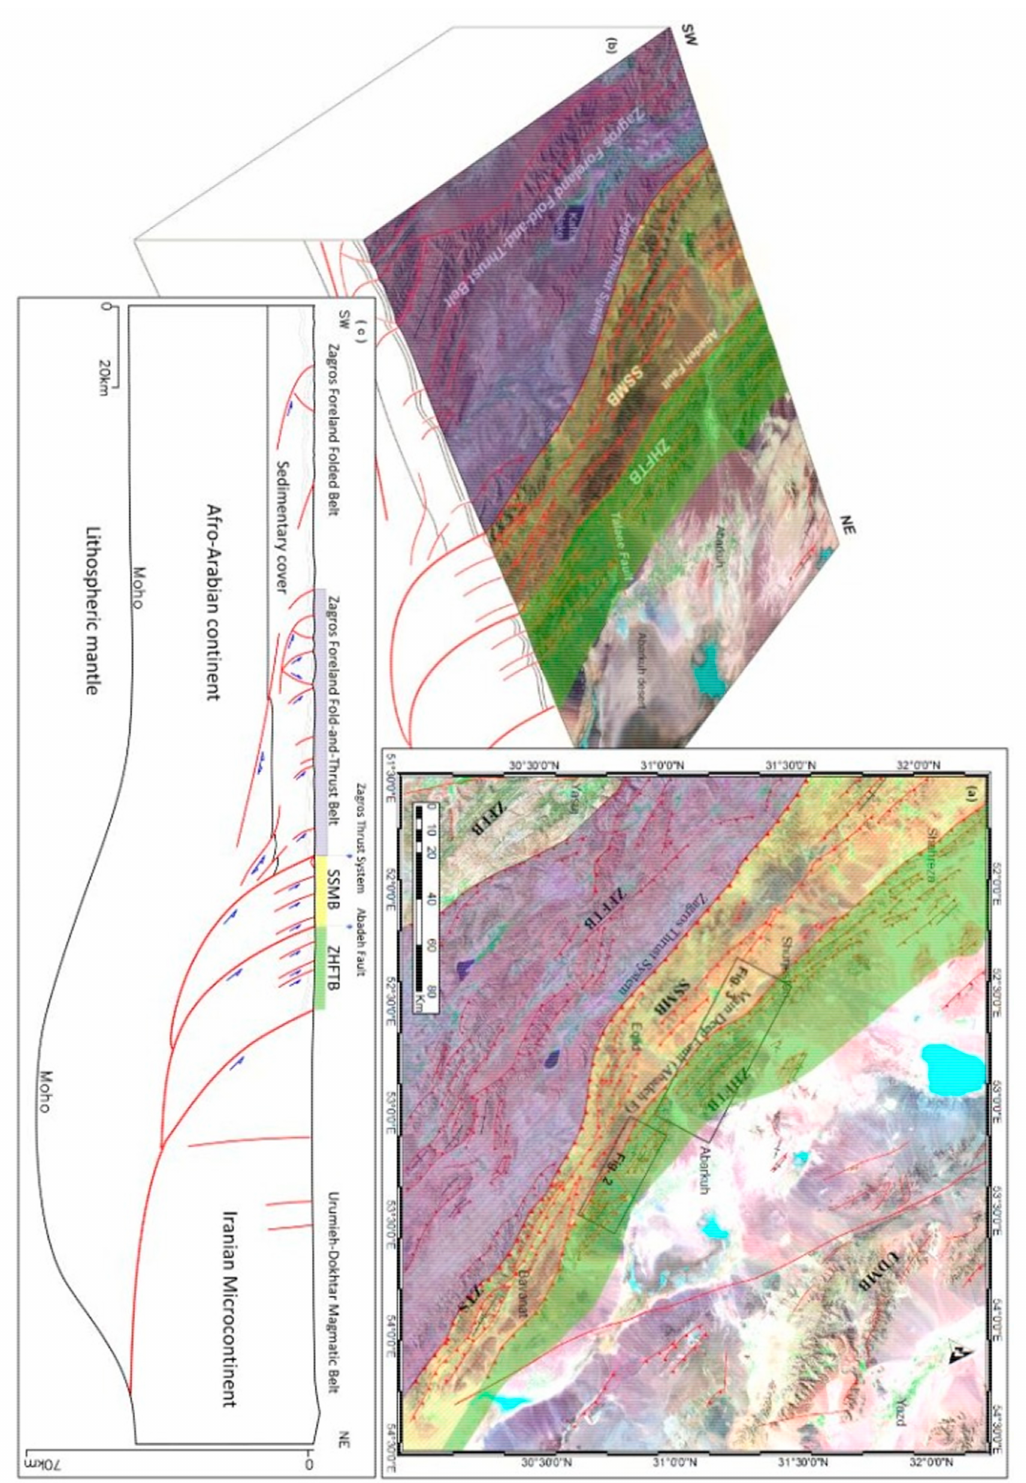
Figure 2. ( a ) Satellite image (from MrSID, Multi-resolution Seamless Image Database) showing the main structures of the study area and the main subdivisions of the central part of the Zagros collision belt near the Zagros thrust system; ( b ) Crustal-scale block diagram of the central part of the Zagros collision belt; ( c ) A schematic cross-section of Zagros showing its structural zones. The depth of Moho is adapted from [9] and the depth of the basement in the Afro-Arabian continent is adapted from [11]. The structures of the Zagros foreland fold-and-thrust belt and Zagros foreland folded belt are adapted from